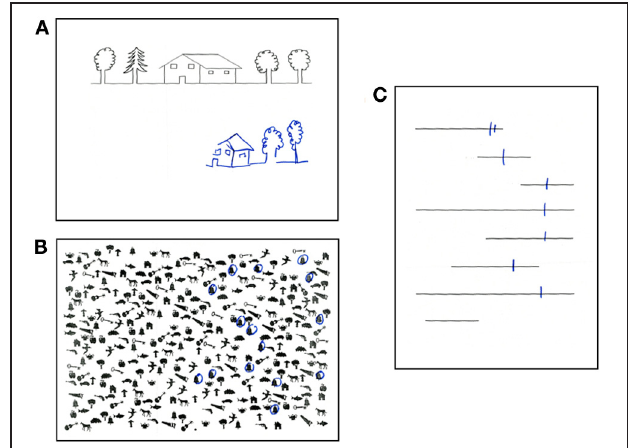
FIGURE 2 | Performance of a patient with left spatial neglect on paper-and-pencil tests. (A) copy of a linear drawing with omission of left-sided elements; (B) target cancellation task, with omission of left-sided targets (bells); (C) bisection of horizontal lines, with rightward deviation of the bisection mark and complete omission of one left-sided